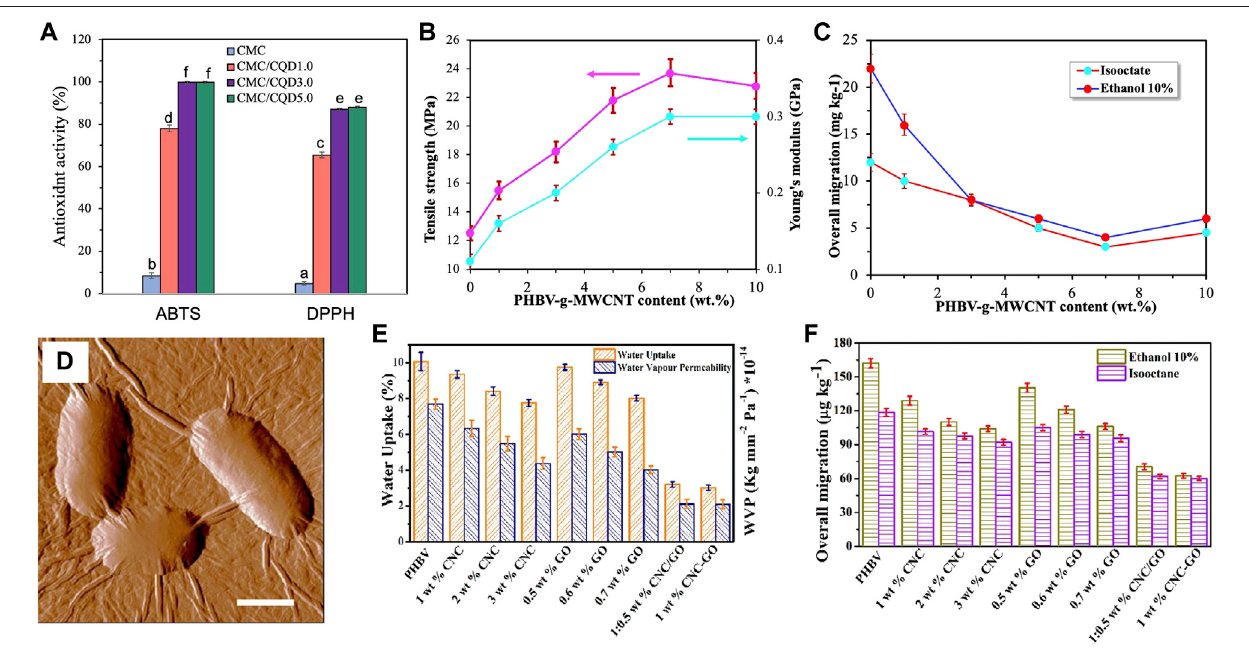
FIGURE 11 | (A) Antioxidant activity of CD-cellulose composite fi lms using ABTS and DPPH methods. Redrawn from Riahi et al. (2022). (B) Tensile strength and Young ’ s modulus of PHBV composite fi lms incorporated with different PHBV-g-MWNT contents. (C) Overall migration of isooctane and ethanol (10%) in the PHBV composite fi lms incorporated with different PHBV-g-MWNT contents. Redrawn from Yu et al. (2014). (D) AFM amplitude image of E. coli cells after incubation with GO nanosheets.Thescalebaris1 μ m.ReprintedwithpermissionfromLiuetal.(2012).Copyright2012AmericanChemicalSociety. (E) Wateruptakeandwatervapor permeability in the PHBV composite fi lms incorporated with CNC-GO hybrids. (F) Overall migration of ethanol (10%) and isooctane in the PHBV composite fi lms incorporated with CNC-GO hybrids. Reprinted with permission from Li et al. (2019b) Copyright 2019 American Chemical